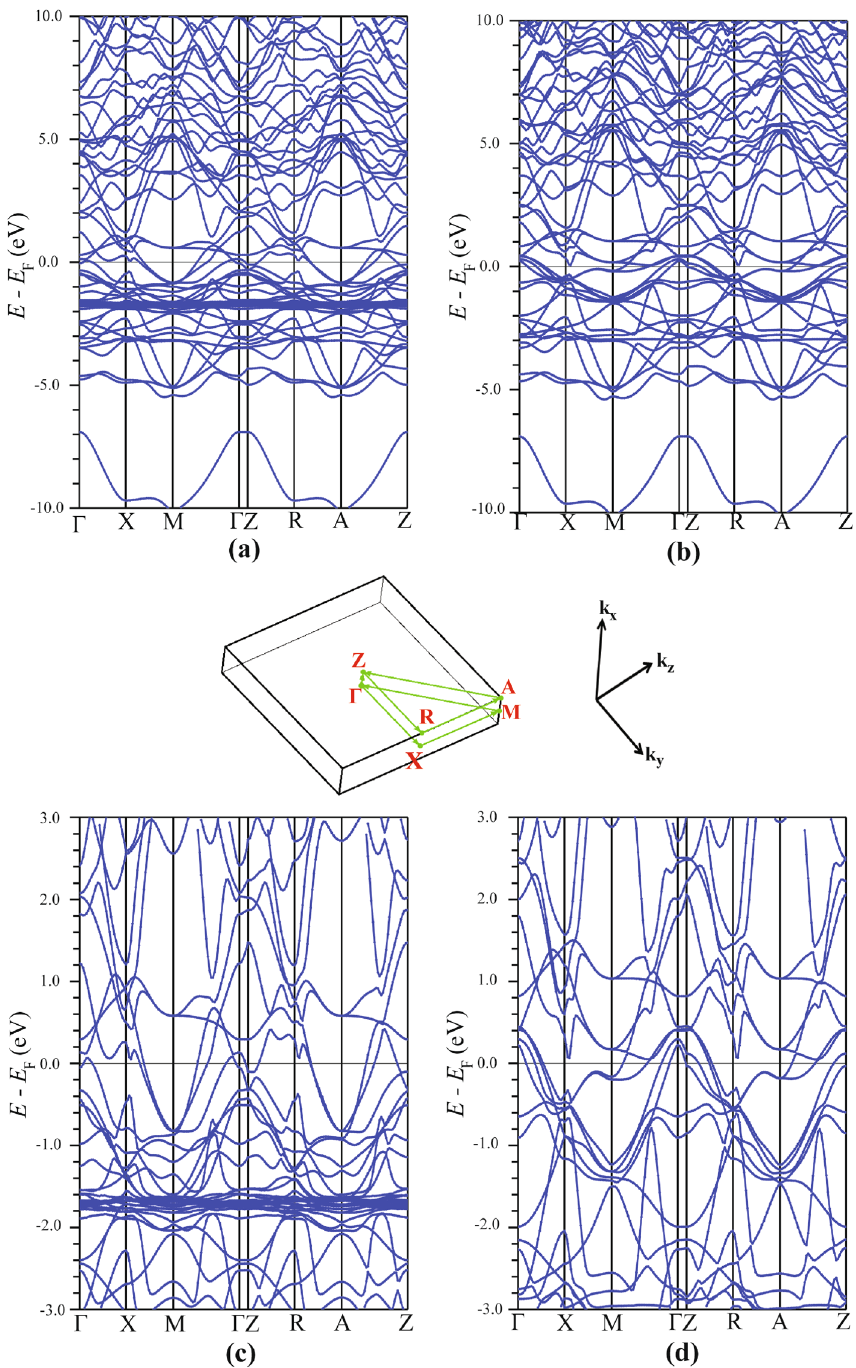
Figure 6. Spin-polarized band structure of EuFeAs 2 in the high-symmetry directions of the conventional Brillouin zone. The spin-up ( a ) and spin-down ( b ) band structure in the energy range between − 10 and 10 eV. The spin-up ( c ) and spin-down ( d ) band structure close to the Fermi level. The k -paths along the high symmetry directions are shown in the middle of the figure. SigmaPlot v14, www. systa tsoft ware.